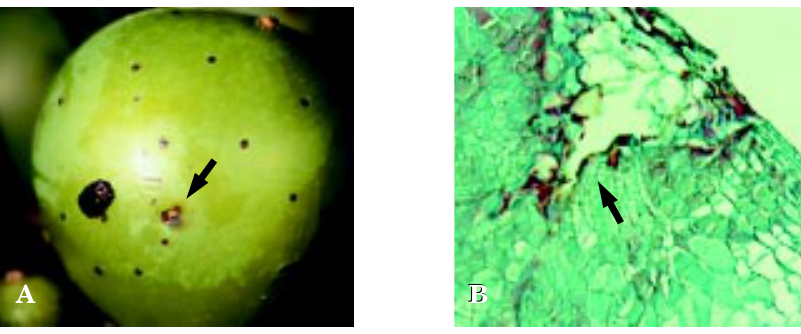
Fig. 2. A. Wound (arrow) produced on grape cv. Chardonnay 10 days after pricking and inoculation with distilled water, 10 (cid:1) . B. Paraffin section of wound area showing periderm formation (arrow) (400 (cid:1)